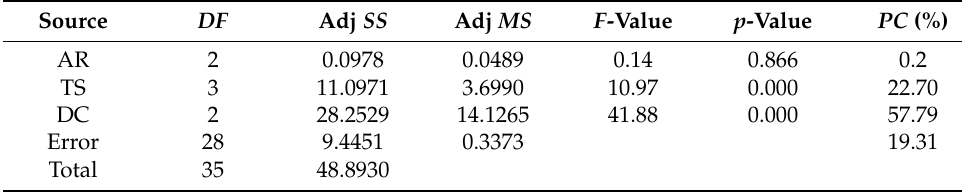
Table 8. ANOVA results for the 10 mm material